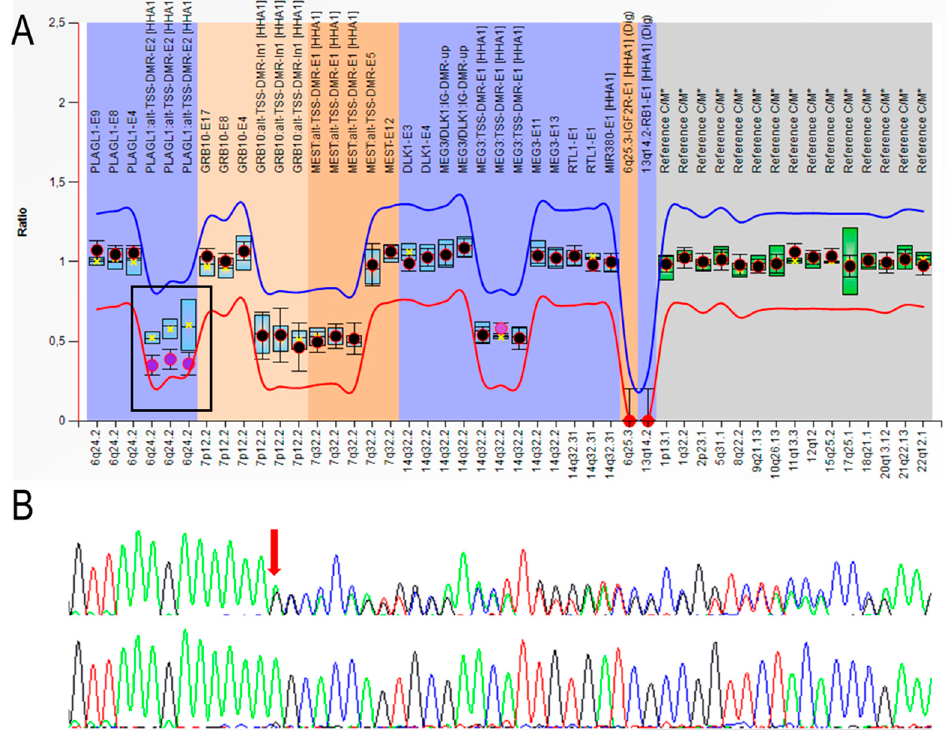
Figure 3. ( A ) Partial hypomethylation in PLAGL1: alt-TSS-DMR (framed) revealed in ME032-A1 kit analysis, represented with Coffalyser. Probe results indicate significantly decreased signals compared to the reference samples as a decrease of more than two standard deviations. The red and blue lines indicate the arbitrary borders for loss and gain, respectively (by default, the borders are placed ± 0.3 from the mean probe value of a probe over the reference samples). Black dots display the probe ratios of the patient’s sample, and the error bars the 95% confidence ranges. The blue and green box plots in the background show the 95% confidence range of the used reference samples, the yellow star indicates the mean. When a probe ratio crosses the borders, it is indicative for a gain or loss (black dot surrounded in red) of methylation. Full red dots correspond to internal controls of HhaI digestion. ( B ) Electropherogram of the confirmatory direct sequencing of identified pathogenic variant in the PLAG1 gene. Upper panel belongs to the proband, showing NM_002655: c.551delA; p.(Lys184Serfs *45) heterozygous variant (arrow) and the lower one is a wild-type sequence.